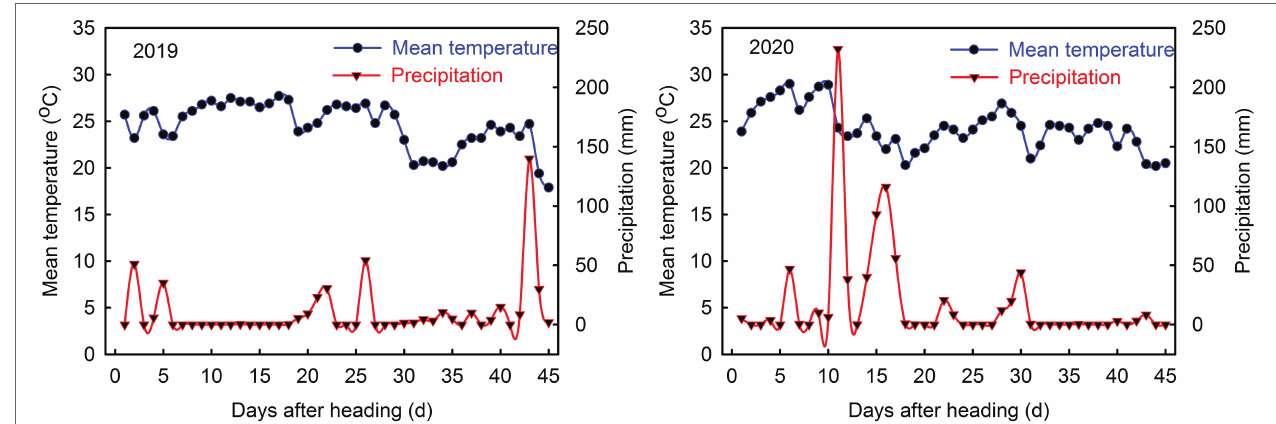
FIGURE 1 | Mean temperature and precipitation during rice grain-filling from Wenjiang experimental field in 2019 and